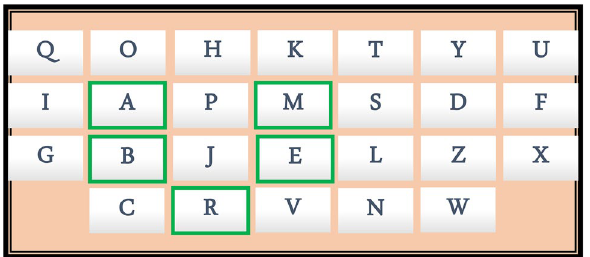
Figure 8. Keypad lock for accessing the secret password generated by sequential chemical inputs of AcO − and F − resulting absorption signals at 348 nm and 401 nm respectively.